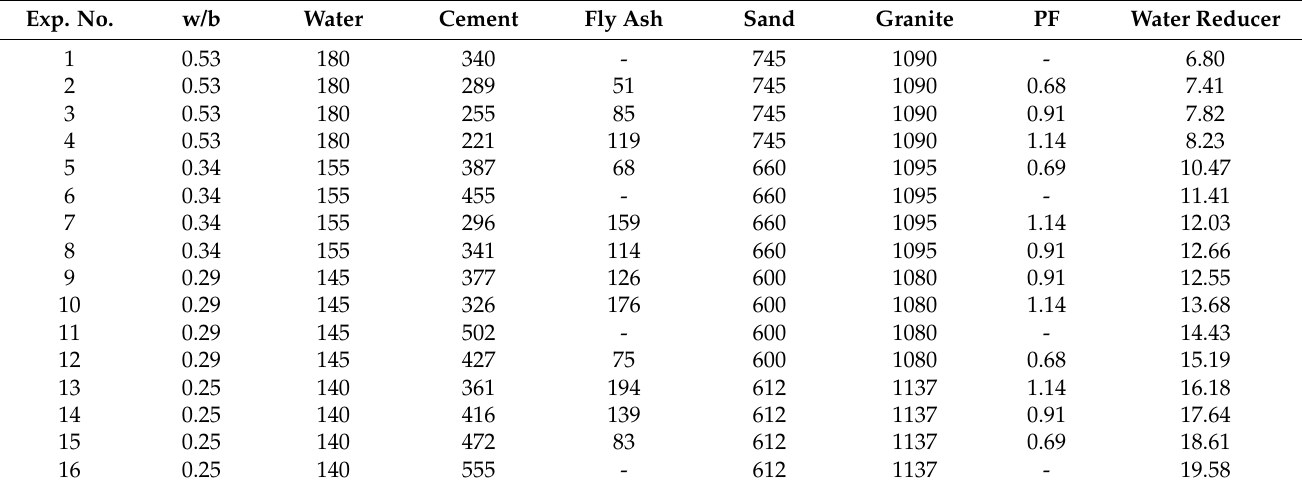
Table 6. Mix proportion of experimental concrete (kg/m 3